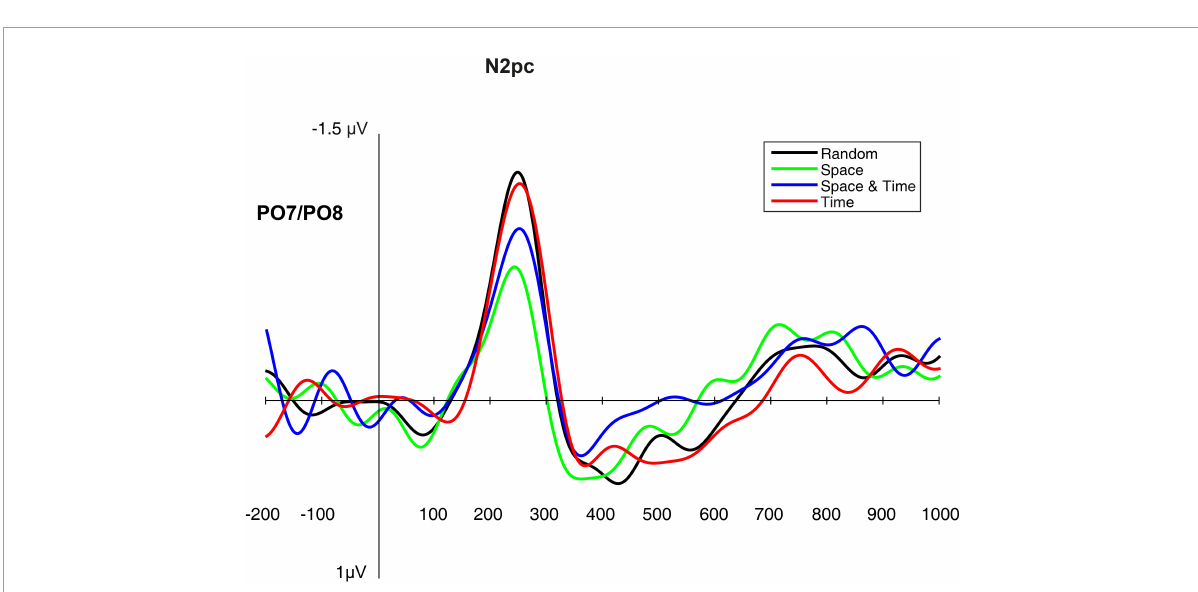
FIGURE8 The N2pc component elicited in the testing phase (mini-blocks 4–6), presented separately for each big